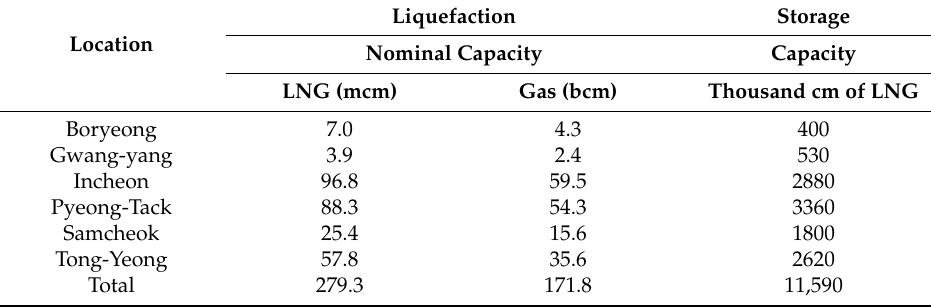
Table 3. Re-gasification and LNG storage capacity of Korea.